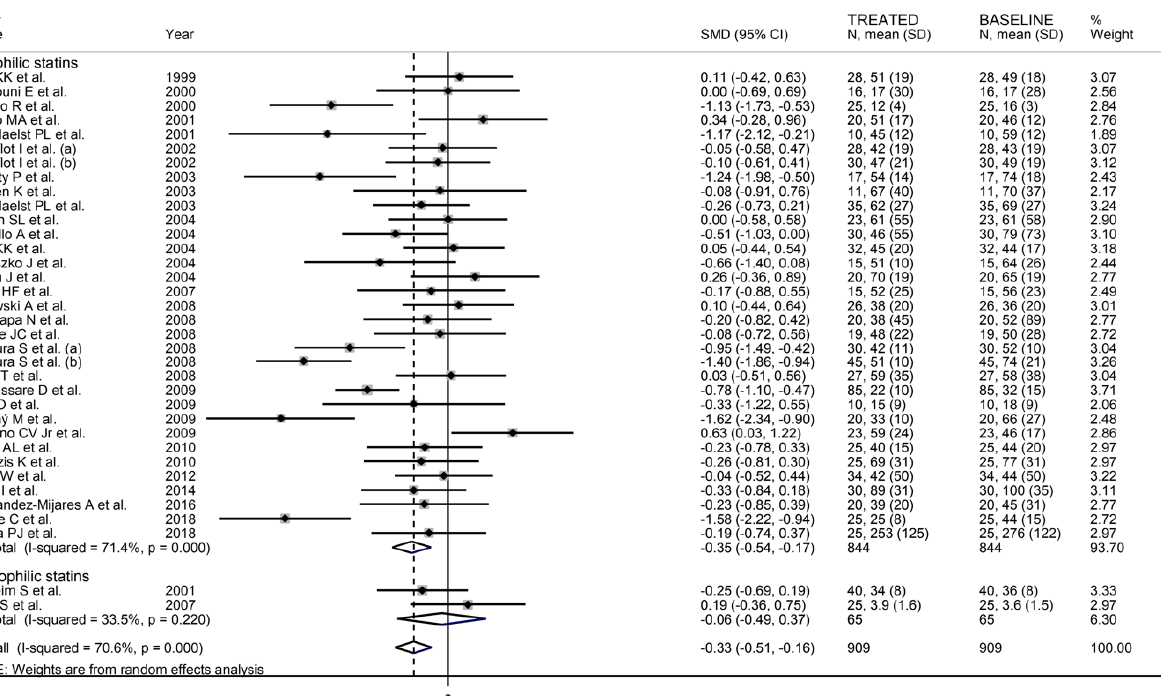
Figure 15. Forest plot of E-Selectin concentrations before and after statin treatment according to individual agents.